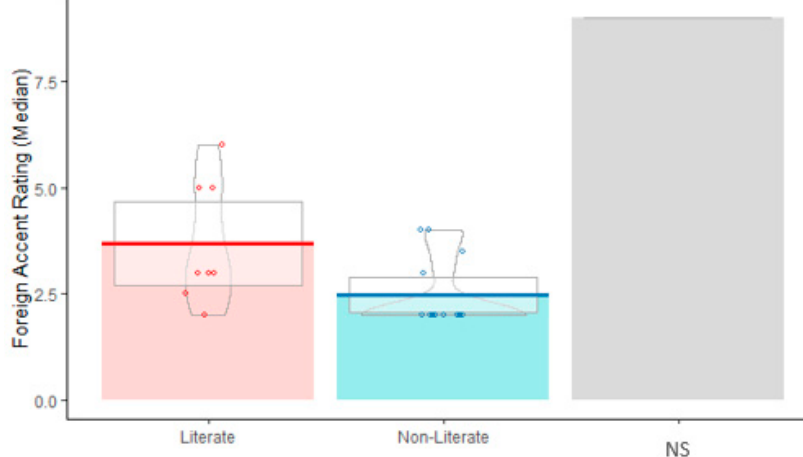
Figure 13. Median and distribution of foreign accent rating scores given to NS and the FDH groups, the latter split according to L1 literacy. the latter split according to L1